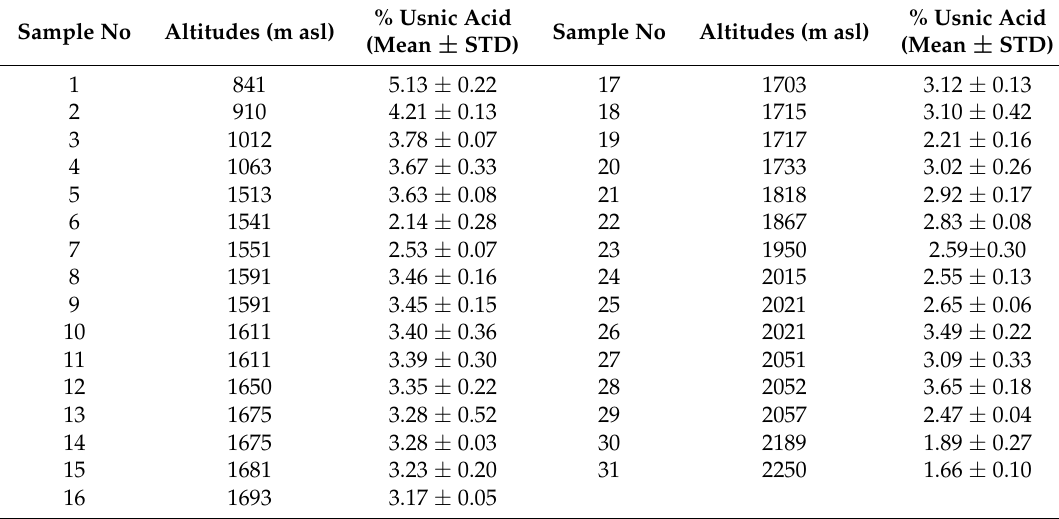
Table 1. Concentration of usnic acid in dry weight of lichen ( n =